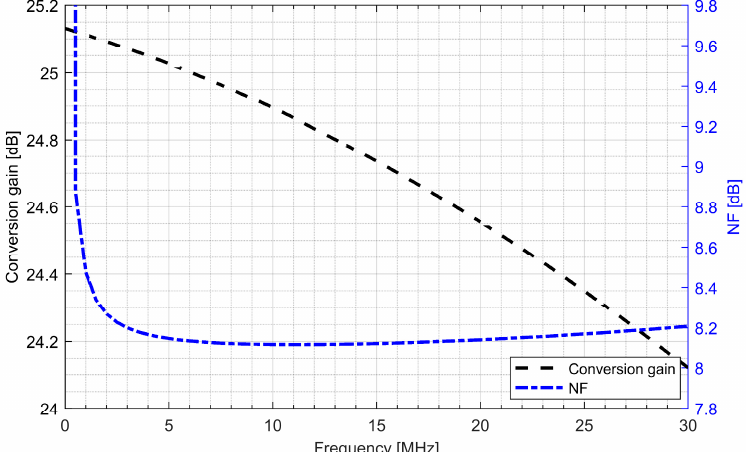
Figure 11. Conversion gain and noise figure characteristics of the L1/E1 band active balun and mixer.